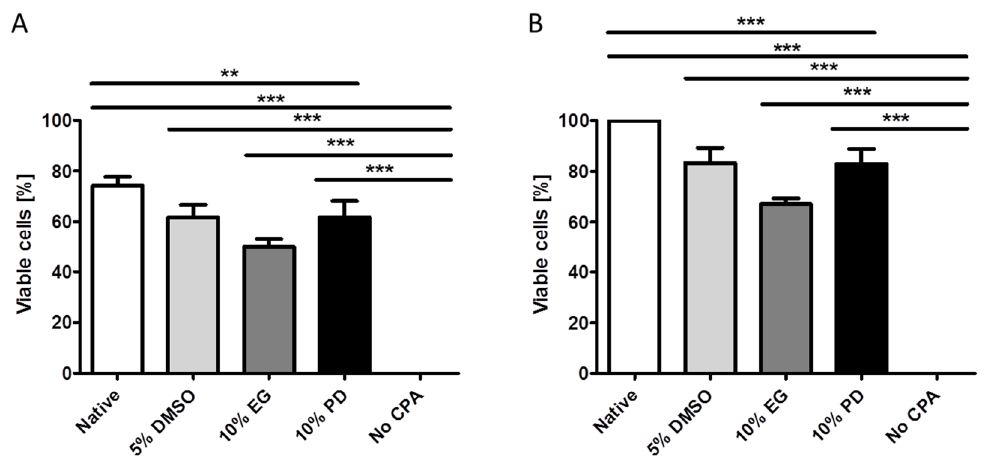
Figure 1. Viability of cell populations containing iPSC-generated MKs harvested at day 19 of differentiation according to trypan blue exclusion viability test. ( A ) Absolute values of number of viable cells after cryopreservation with 5% DMSO, 10% EG, and 10% PD, as well as viability in the positive (native) and negative (cryopreservation without CPA) controls. ( B ) Relative values of the number of viable cells after cryopreservation with 5% DMSO, 10% EG, 10% PD, and in the absence of CPA, normalized against the native control. The data is presented as mean ± SD. **—significant difference to native control, p < 0.01; ***—significant difference to native control, p < 0.001.